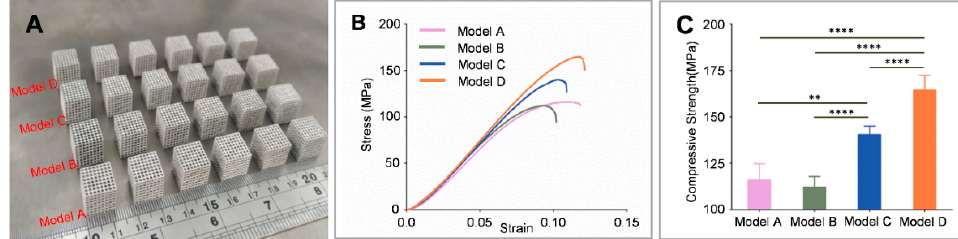
Figure 6. ( A ) As ‐ built scaffolds. ( B ) Stress ‐ strain curves of the compression tests of scaffolds. ( C ) Figure 6. ( A ) As-built scaffolds. ( B ) Stress-strain curves of the compression tests of scaffolds. ( C ) Com- Compressive strength of scaffolds ( n = 6). Statistical analysis: one ‐ way ANOVA (* p < 0.05; ** p < pressive strength of scaffolds ( n = 6). Statistical analysis: one-way ANOVA (* p < 0.05; ** p < 0.01; 0.01; *** p < 0.005; **** p < 0.001). *** p < 0.005; **** p < 0.001).